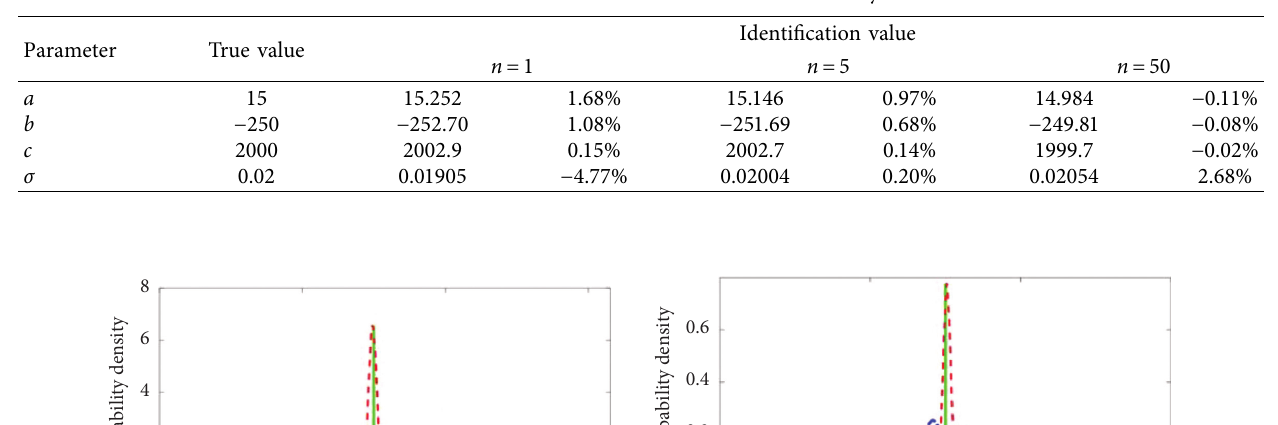
Figure 6: Boxplots of 50 sets of virtual experimental natural frequencies. Table 2: Parameter identification results in case study 1.